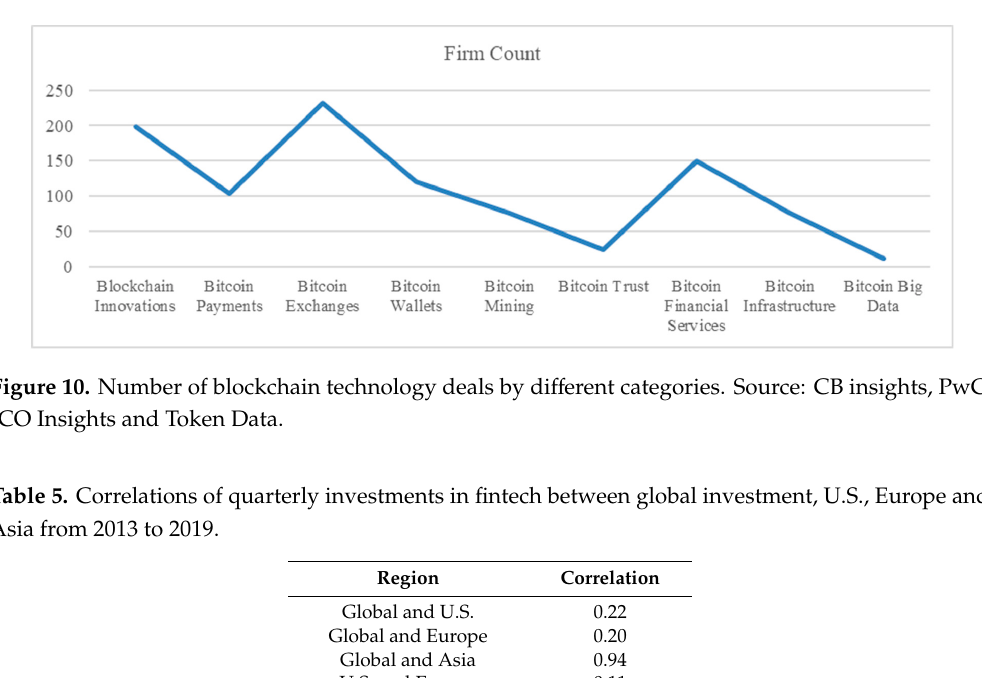
Figure 9. Blockchain Technology investment by different categories. Source: CB insights, PwC, ICO Insights and Token Data.